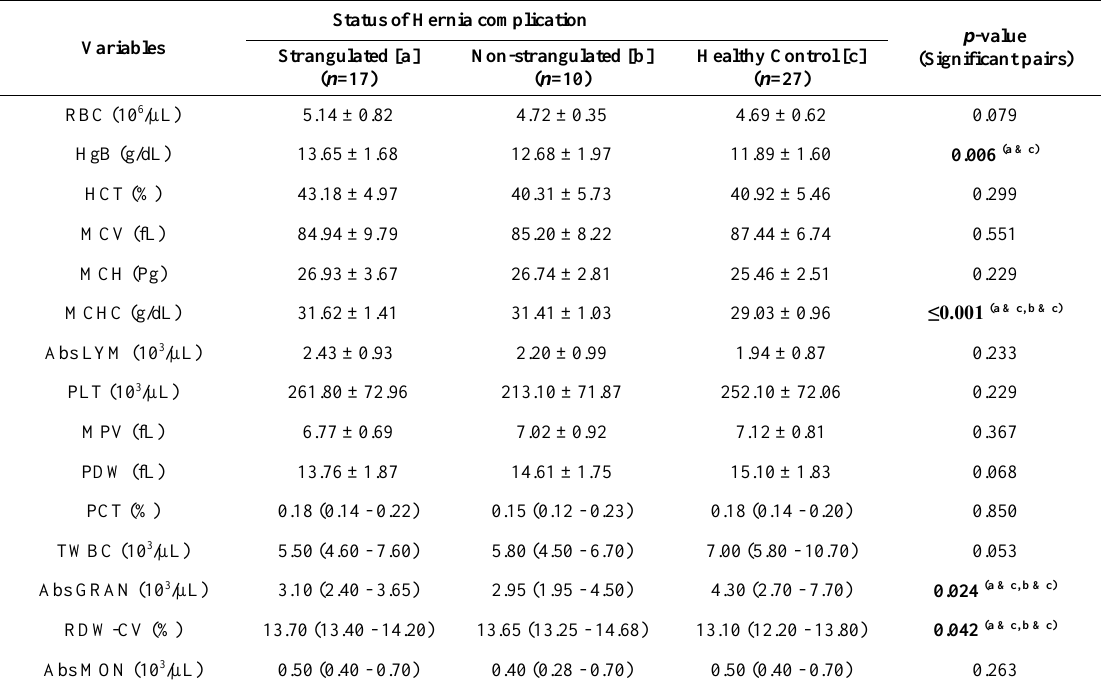
Table 2. Haematological profile of participants stratified by hernia-associated complications (strangulated and non- strangulated) and control